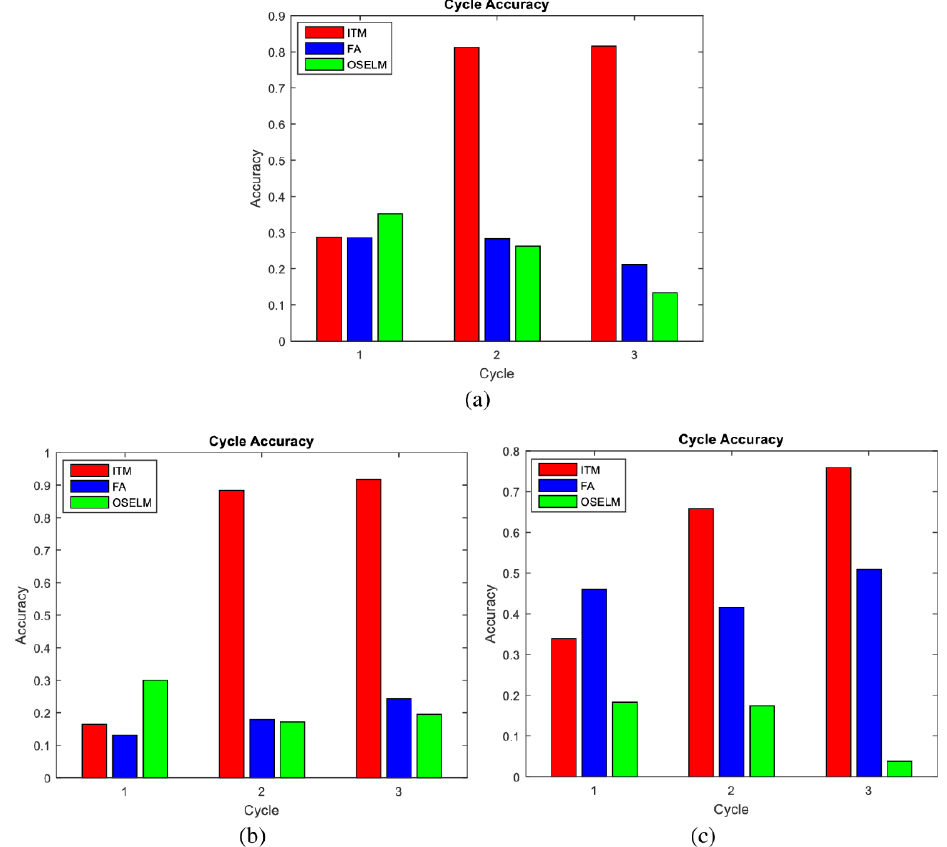
Figure 9. Overall accuracy for the three models with respect to cycles. ( a ) TampereU; ( b ) UJIndoorLoc; and ( c ) KDD99 datasets.